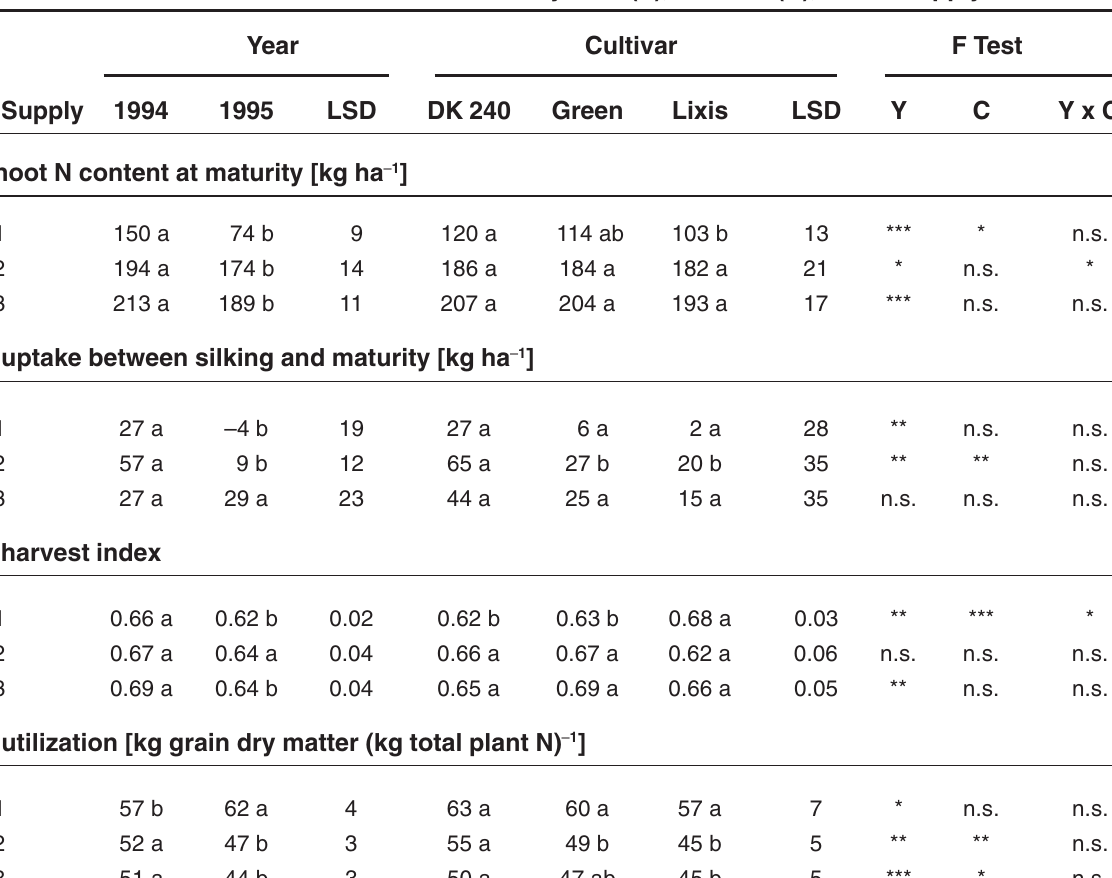
Shoot N Uptake at Maturity, N Uptake between Silking and Maturity, NHI and N Utilization of Maize as Influenced by Year (Y), Cultivar (C), and N